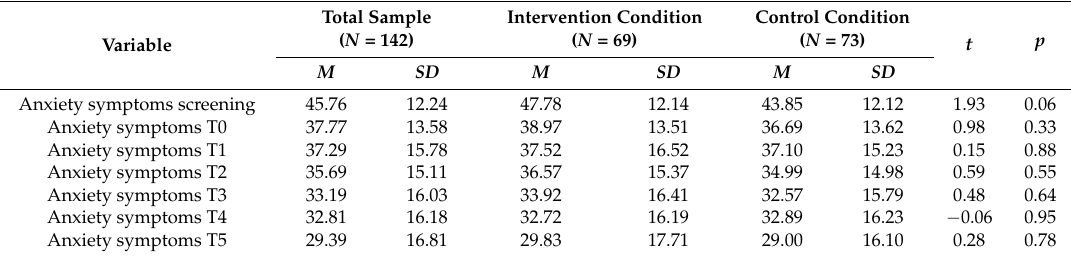
Table 3. Means, standard deviations, and t -values for differences on anxiety symptoms between the intervention and control condition. Total Intervention Sample Variable